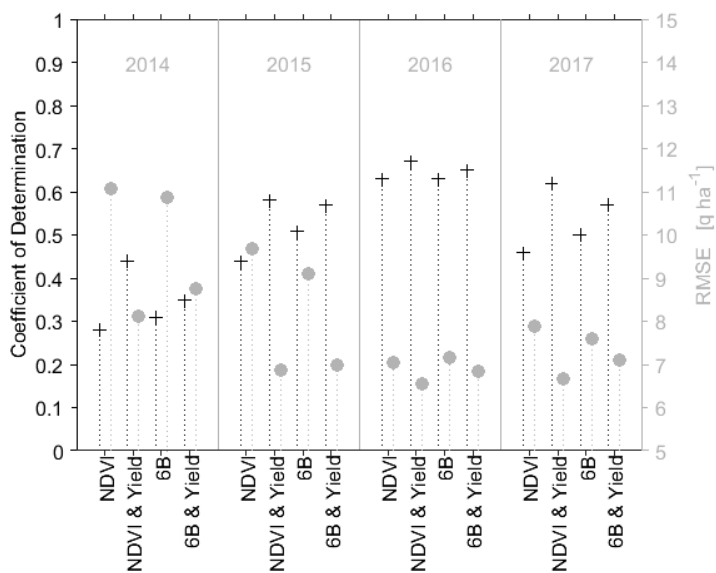
Figure 3. Statistical performance (coefficients of determination and root mean square errors, in black and gray, respectively) associated with the estimation of the intra-plot wheat yields, for the years 2014, 2015, 2016 and 2017.